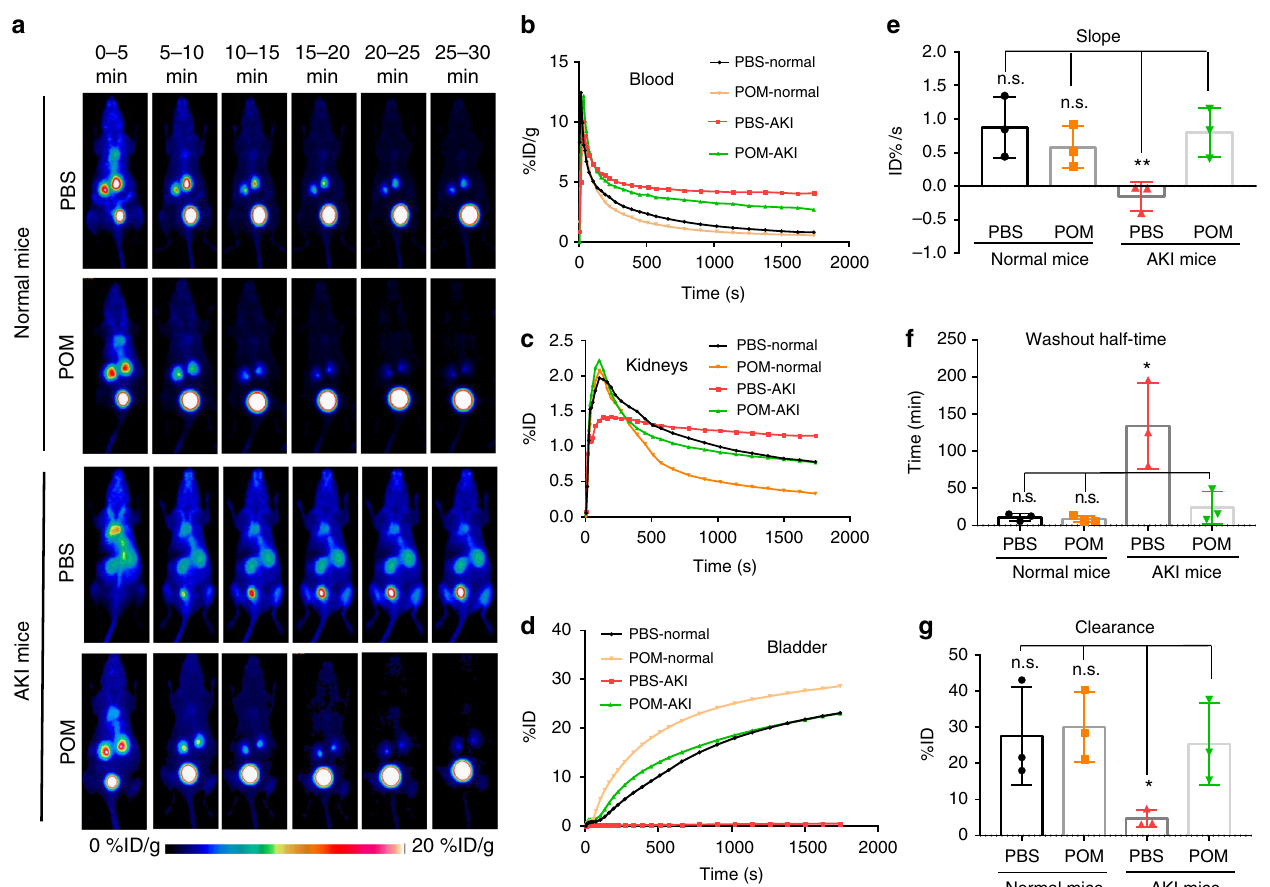
Fig. 4 Dynamic PET imaging with 68 Ga-EDTA tracer for evaluation of renal functions. a Representative PET imaging of normal mice, AKI mice treated with PBS and POM nanoclusters respectively. b ROI analysis of signals in the blood pool; lower signal denotes better excretion of 68 Ga-EDTA. c ROI analysis of signals in the kidneys; sharper peak denotes better excretory functioning of the kidneys. d ROI analysis of signals in the bladder; higher signal in the bladder denotes better functioning of the kidneys. e The slope of renal ROI curve between 1 and 2 min p.i. of 68 Ga-EDTA; a positive slope indicates proper functioning of the kidneys. f Washout half-time of renal ROI curve (time interval between the peak tracer value and half of the peak value); shorter time de fi nes better renal excretion, further suggesting better recovery of kidney function from AKI after treatment. g Clearance of 68 Ga-EDTA into the bladder; higher clearance indicates better excretion and better treatment ef fi cacy of AKI. In e – g , data represent means ± s.d. from three independent replicates, and P values were calculated by two-tailed Student ’ s t -test (* P < 0.05; ** P < 0.01; n.s., no signi fi